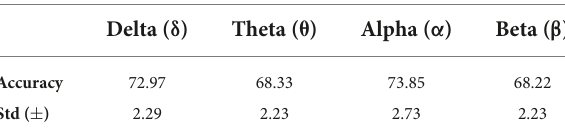
TABLE 1 Classification accuracy and standard deviation (std) of electroencephalography ( EEG ) band powers using linear discriminant analysis ( LDA ).